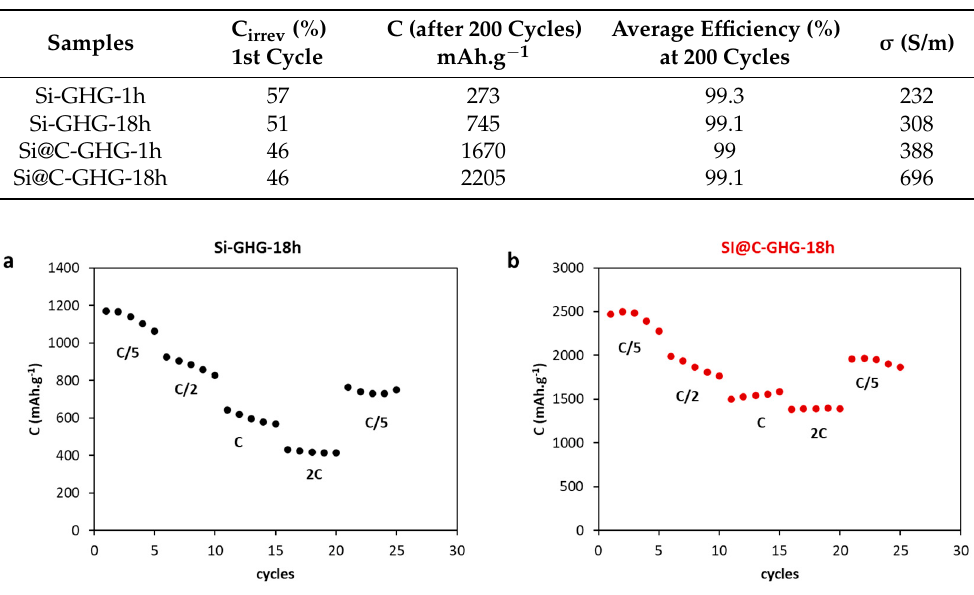
Figure 7. Rate capability tests at several C rates for Si-GHG-18h ( a ) and Si@C-GHG-18h ( b ) samples in half-cells .